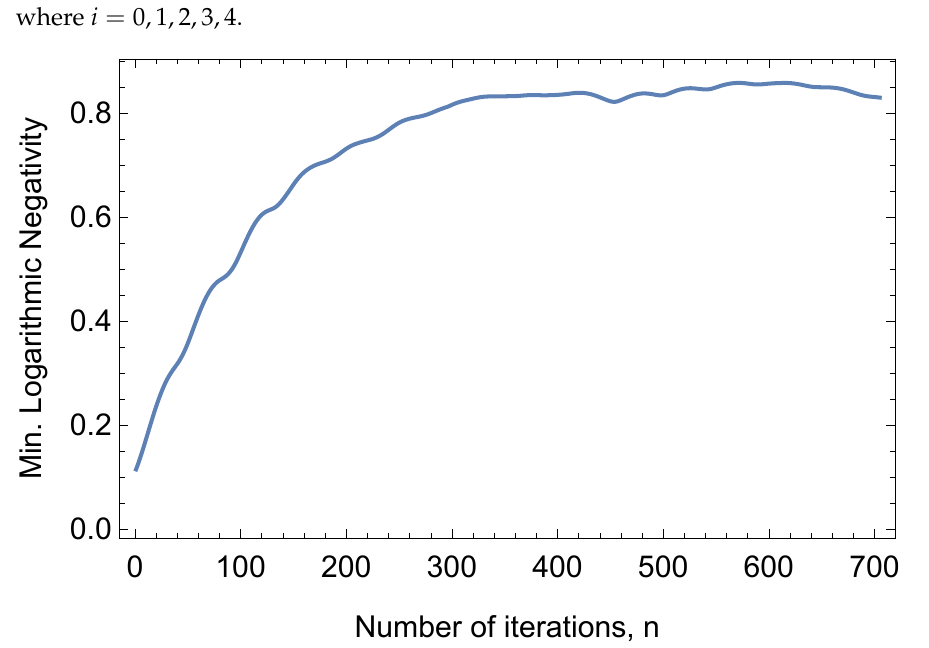
Figure 7. Minimum logarithmic negativity of all bipartite cuts of the eight-qubit system after n )) . Obtaining m > 0 implies no separable iterations of QZD procedure, i.e., m : = min i ( LN ( ρ n i :8 − i bipartite cut, therefore, superactivation of bound entanglement among all the qubits of the network.